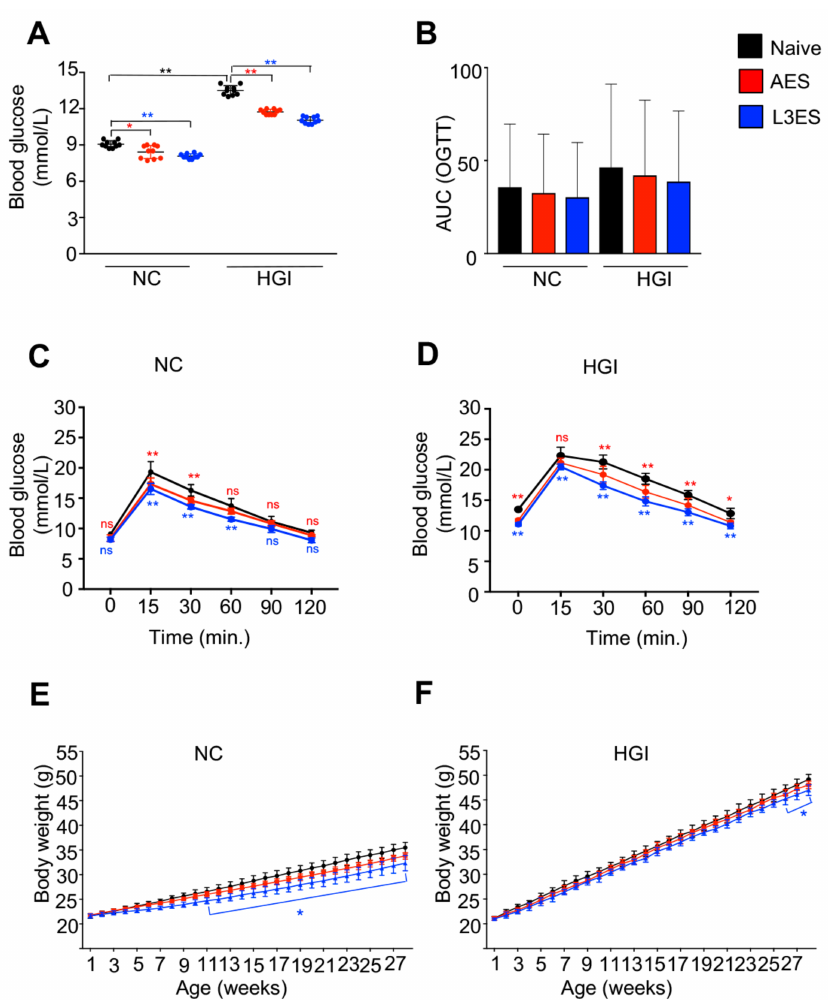
Figure 2. Treatment of six-week-old mice with excretory/secretory (ES) products derived from Nippostrongylus brasiliensis third-stage larvae (L3ES) or adult worms (AES) resulted in decreased fasting blood glucose (FBG), improved glucose metabolism and reduced weight gain in a high glycaemic index (HGI) model of type 2 diabetes. ( A ) FBG in mice fed on normal control (NC) diet or HGI diet and administered L3ES or AES. ( B ) Area under the curve (AUC) for oral glucose tolerance test (OGTT) data in mice fed on NC or HGI diets and administered L3ES or AES; ( C ) Blood glucose levels in mice fed an NC diet ( C ) or a HGI diet ( D ) and administered L3ES or AES. Body weight of mice fed an NC diet ( E ) or a HGI diet ( F ) and administered L3ES or AES. Statistical significance was determined with Student’s t -text or two-way analysis of variance (ANOVA). Data are expressed as means ± SD from 2 pooled experiments where n = 5/group for each experiment. Naïve vs. AES * (red asterisk), Naïve vs. L3ES * (blue asterisk), Naïve NC diet vs. Naïve HGI diet (black asterisk); * p < 0.05; ** p < 0.01. ns = not significant, p >